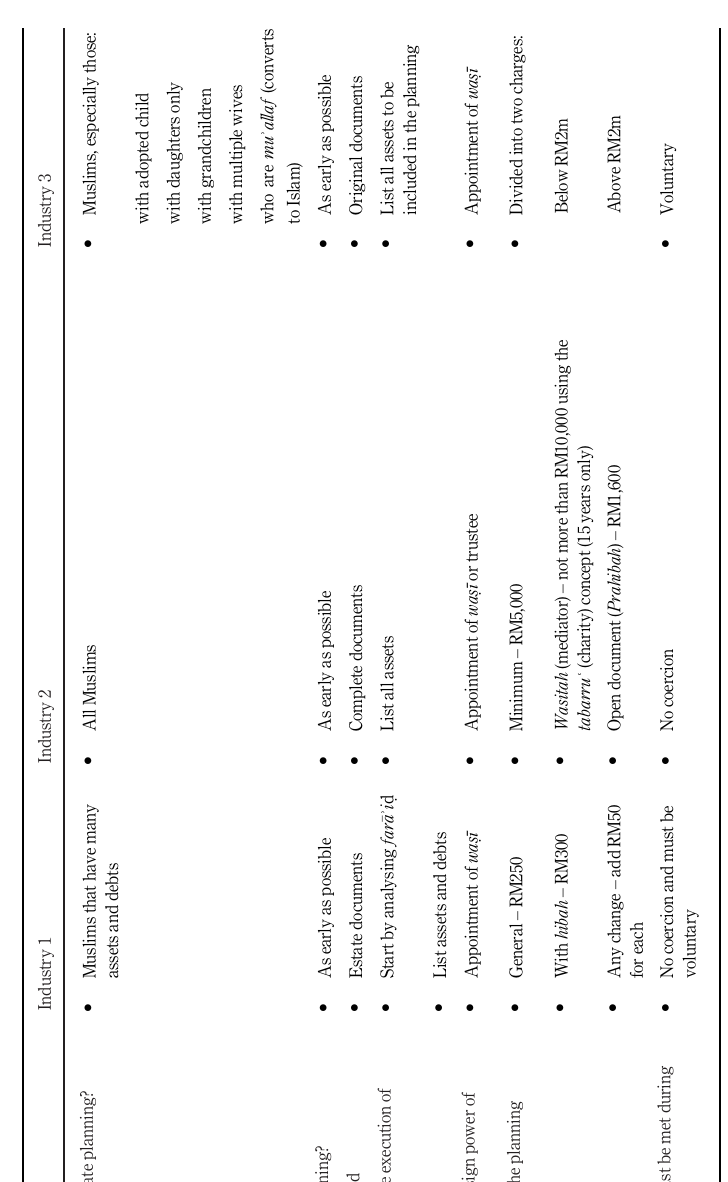
Table 4. Results of best- practised themes of industry